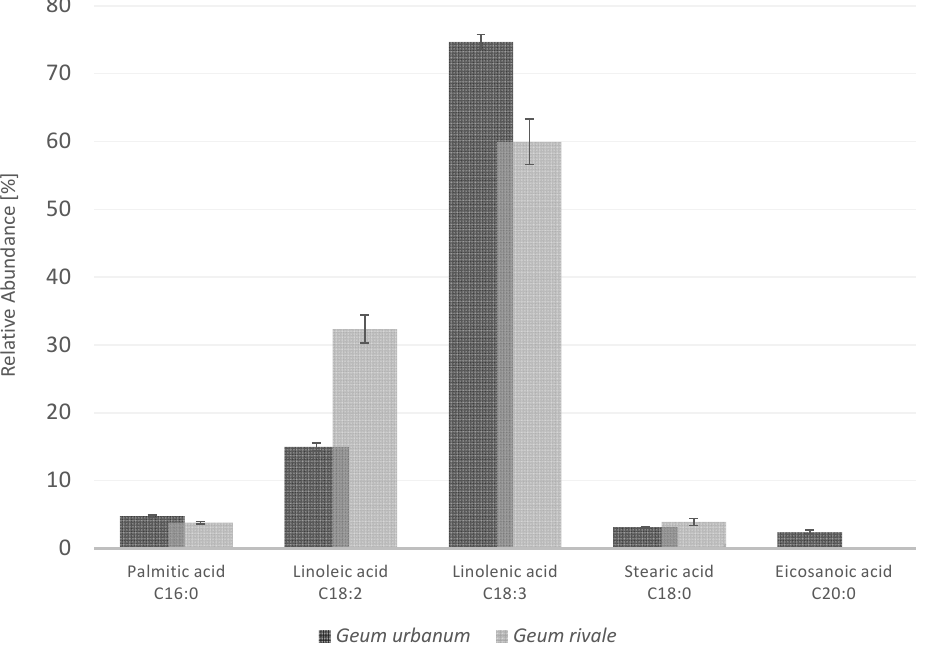
Figure 2. Relative abundance (%) of fatty acids in the seeds of Geum urbanum L. and Geum rivale L. (CH 2 Cl 2 extracted seed oils). Standard errors are given ( n = 3).